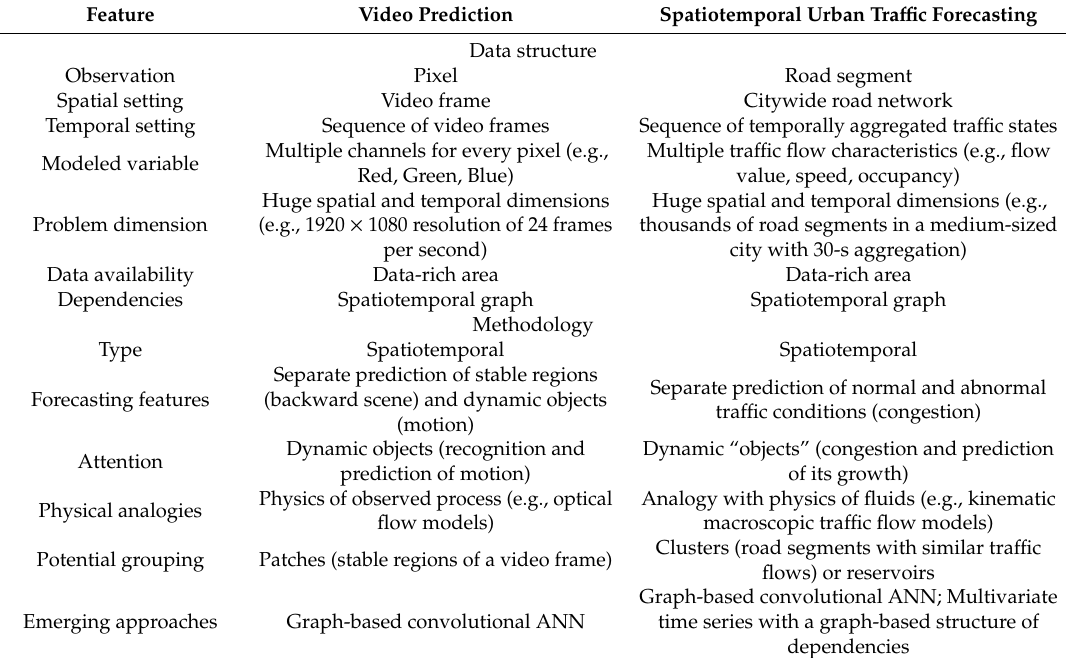
Table 1. Matching video prediction and urban tra ffi c forecasting